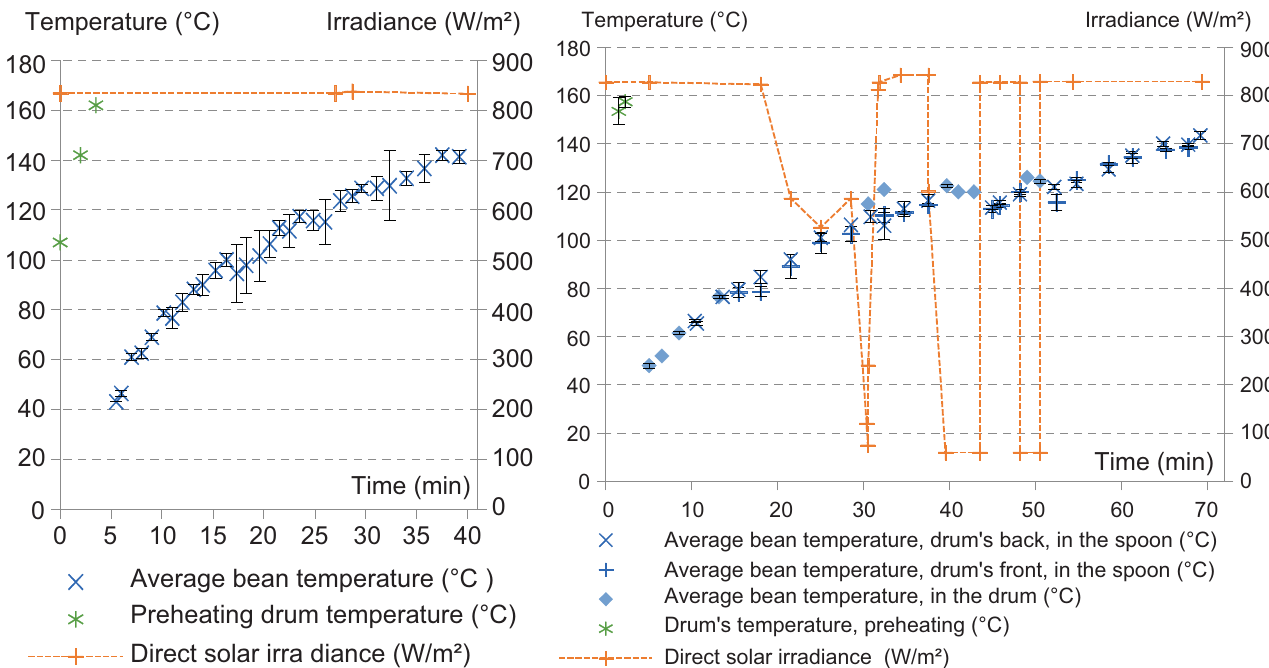
Fig. 2. Left: experiment #2: evolution of preheating drum temperature and roasting cacao temperature. Good direct solar irradiance; Right: experiment #5: evolution of cacao temperature in the drum (front and back) and in the spoon. Direct solar irradiance varying with clouds.